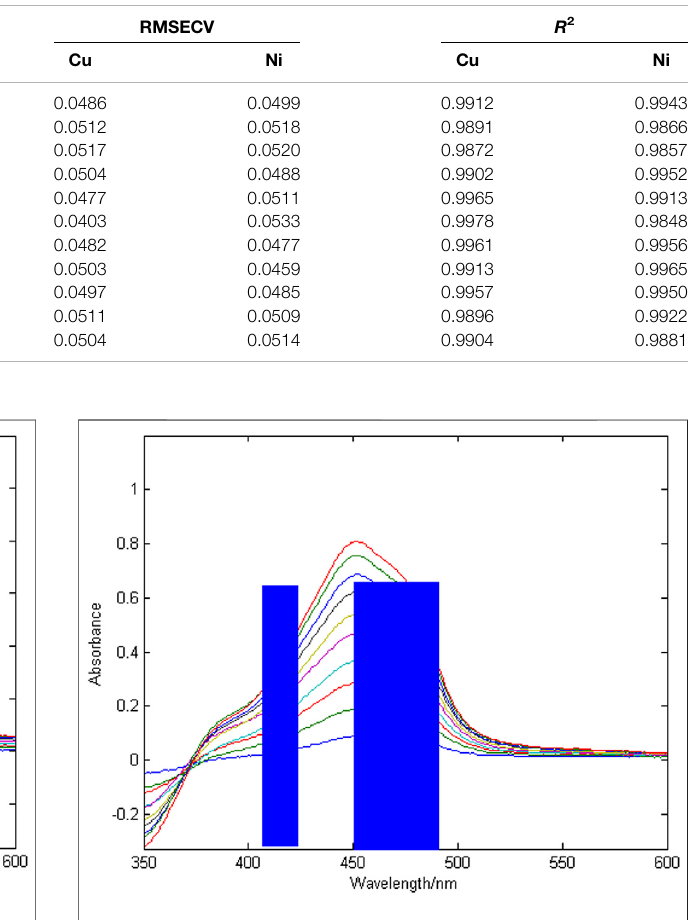
FIGURE 5 | Combined wavelength screening results for copper characteristic intervals.